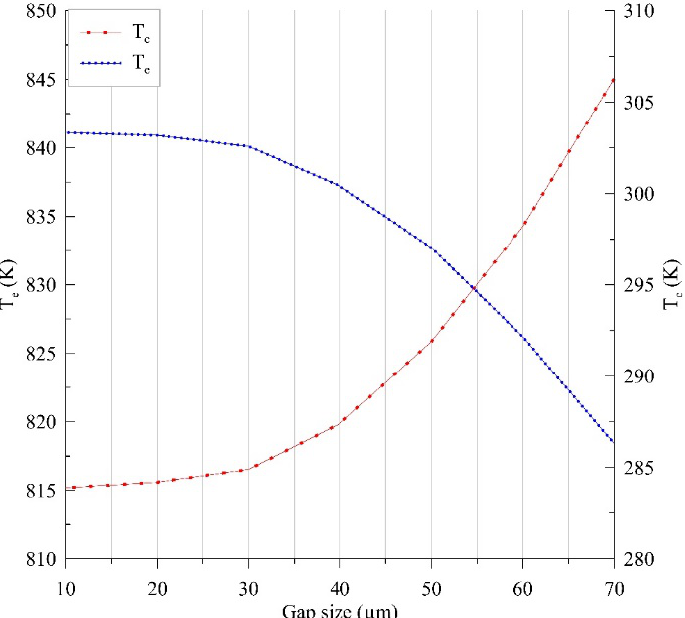
Figure 18. Effect of the gap size on the average gas temperature in the spaces.